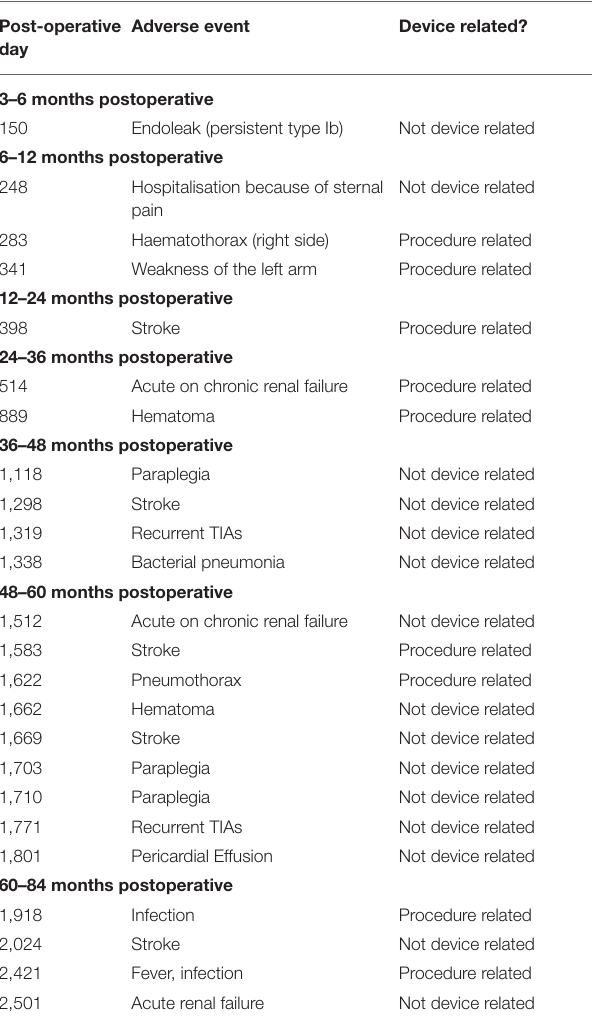
TABLE 5 | Summary of all postoperative adverse events ( n = 59). Summary of postoperative adverse